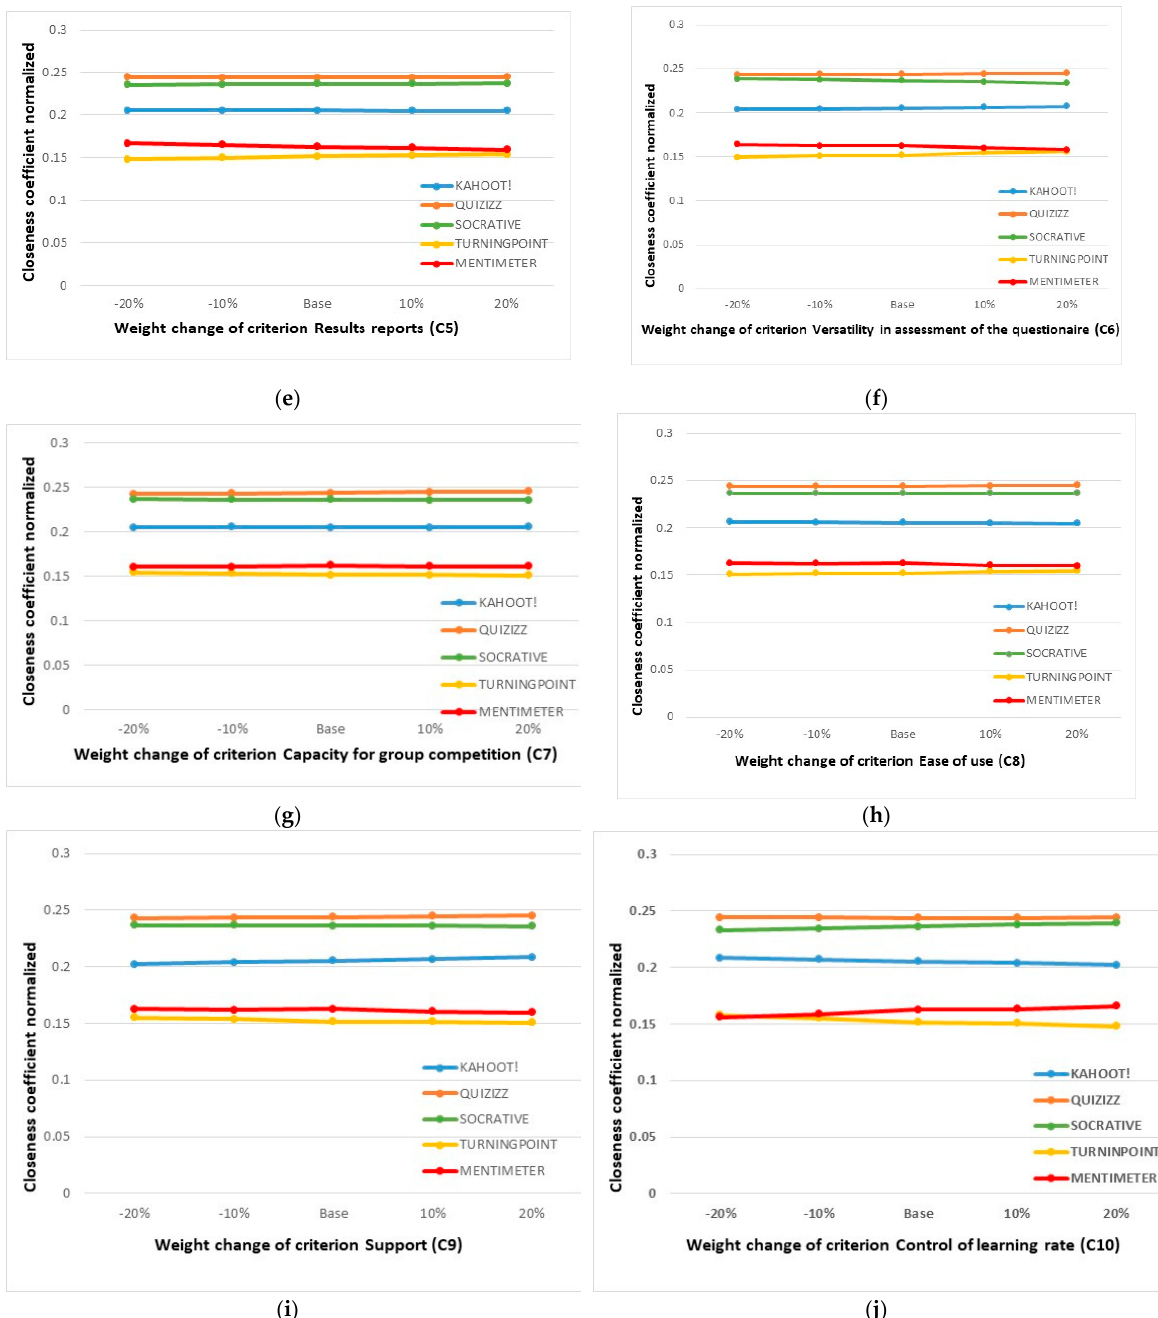
Figure 7. Sensitivity analysis of the model proposed: ( a ) Capacity to combine with other methodologies or novel teaching tools; ( b ) Academic performance; ( c ) Flexibility in the creation of questionnaires; ( d ) Students’ perceptions; ( e ) Results reports; ( f ) Versatility in assessment of the questionnaire; ( g ) Capacity for group competition; ( h ) Ease of use; ( i ) Support; ( j ) Control of learning rate.